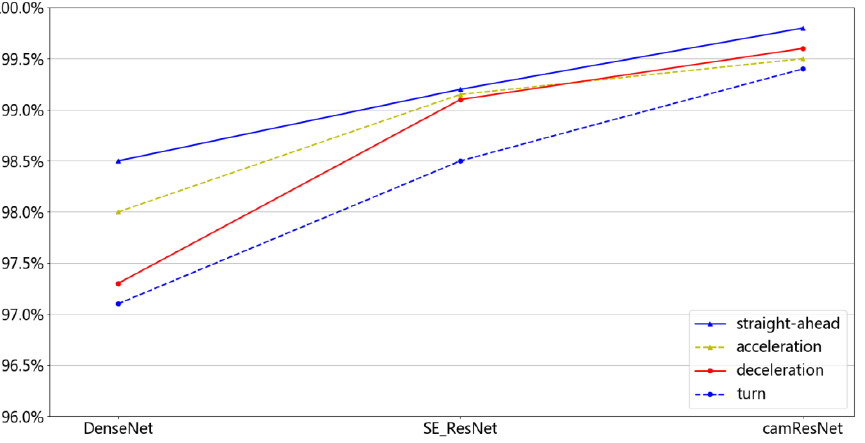
Figure 9. Recognition rate of cooperation targets.